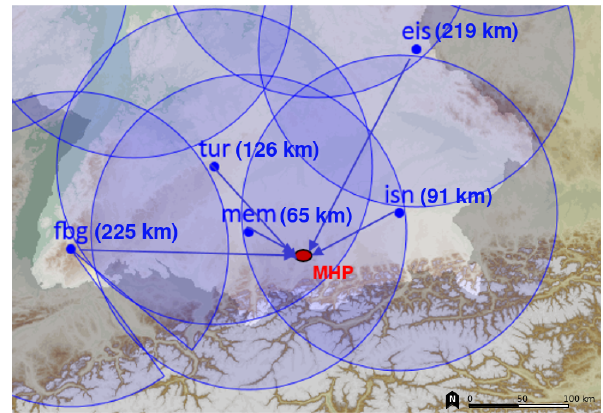
Figure 2. Location of the radars that are used in this test. Shown are the operational systems with distances to MHP (in blue) and the research radar MHP (in red). Circles have a radius of 150km. The arrows towards MHP symbolize the interference scan from opera- tional